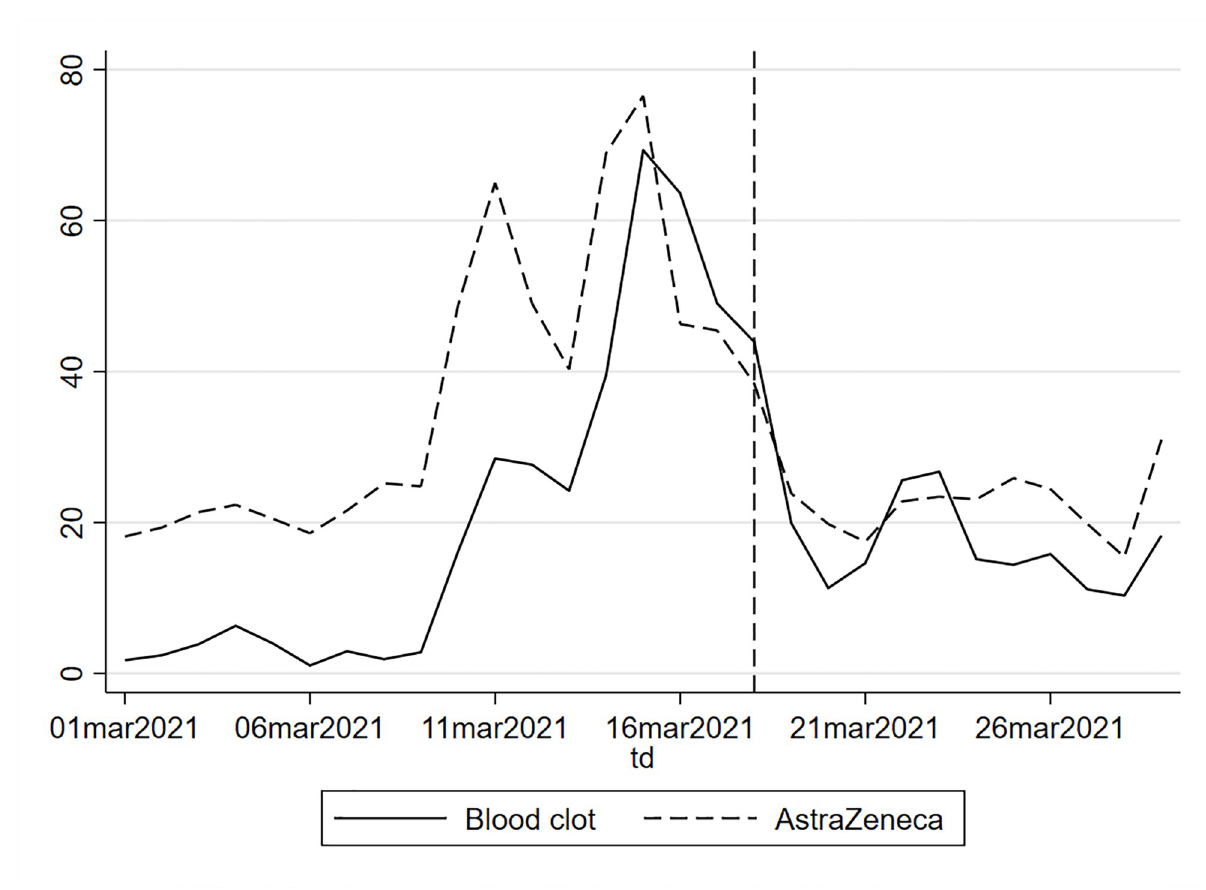
Fig 2. Google Trends searches for “Astrazeneca” and “blood clot” in the Greater Region of Luxembourg. The vertical dashed line indicates the day of the EMA statement. Notes : Google Trends index for searches for “Astrazeneca” and “blood clot” in Luxembourg, Wallonia (Belgium), Saarland and Rhineland-Palatinate (Germany) and Lorraine (France) weighted by regional population size. Moving average over two days.